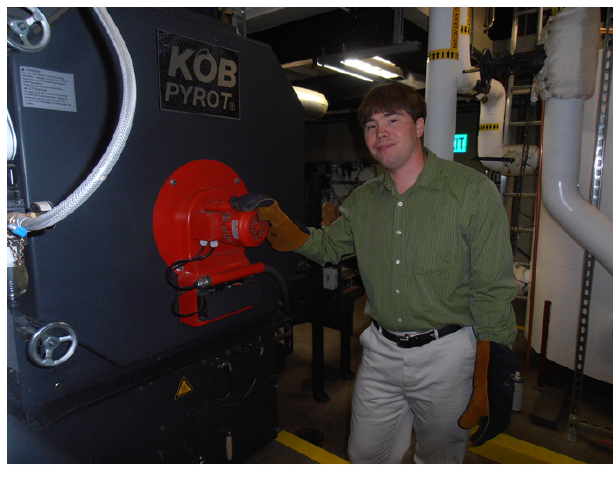
Fig. 2 . Nathan Soboleff, a young Tlingit business leader, displaying Sealaska Corporation’s wood-pellet based boiler, which has significantly lowered the firm’s heating costs and carbon